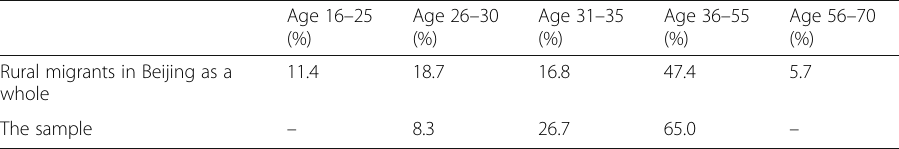
Table 1 A comparison of age distributions between the sample and rural migrants in Beijing as a whole